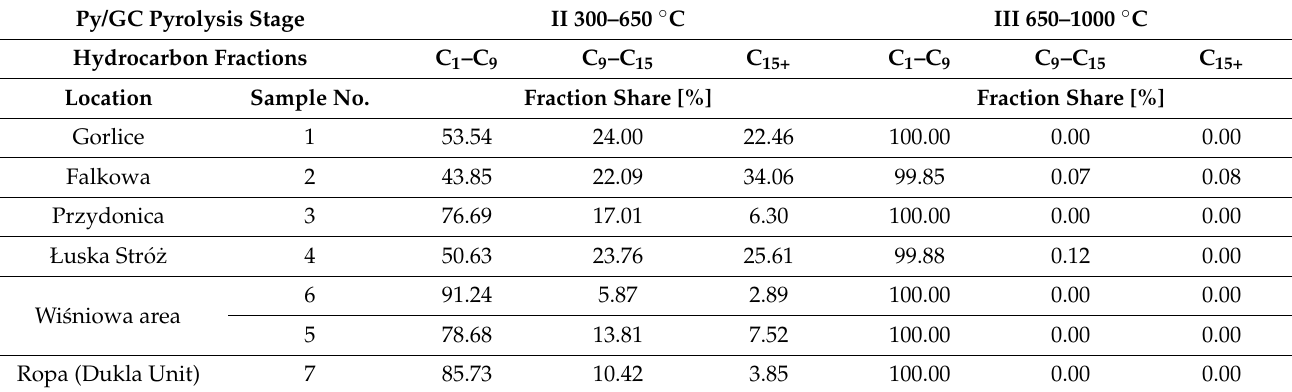
Table 5. Results of Py/GC analysis of the Menilite Bed samples from surface exposures. Py/GC Pyrolysis Stage